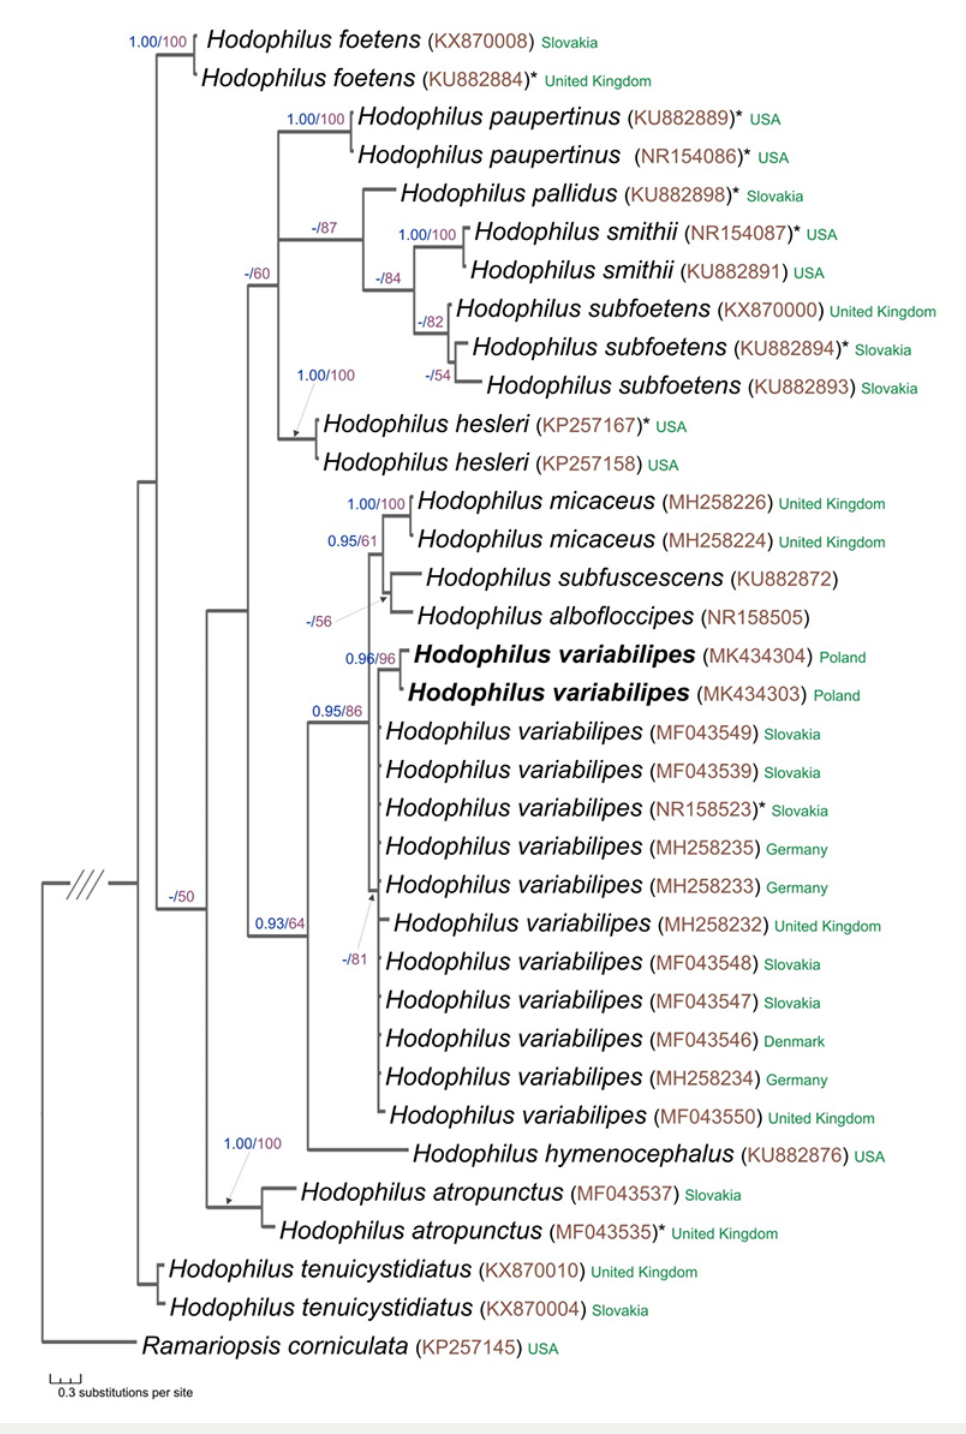
Figure 3 Phylogenetic placement of Hodophilus variabilipes Jančovičová, Adamčík & Looney inferred from ITS rDNA data. The best tree resulting from Bayesian inference analysis is presented with BPP (Bayesian posterior probabilities values) ≥ 0.90 and MLB (maximum likelihood bootstrap percentage) ≥ 50 displayed on the branches. Sequences printed in bold were obtained during this study. The GenBank accession number for each sequence is given in brackets next to the species name. Also included are country names and whether the DNA sequence represents a type collection (labeled by asterisk). Ramariopsis corniculata was used as an